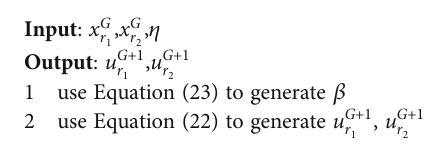
Algorithm 2: SBX operator for the i -th gene